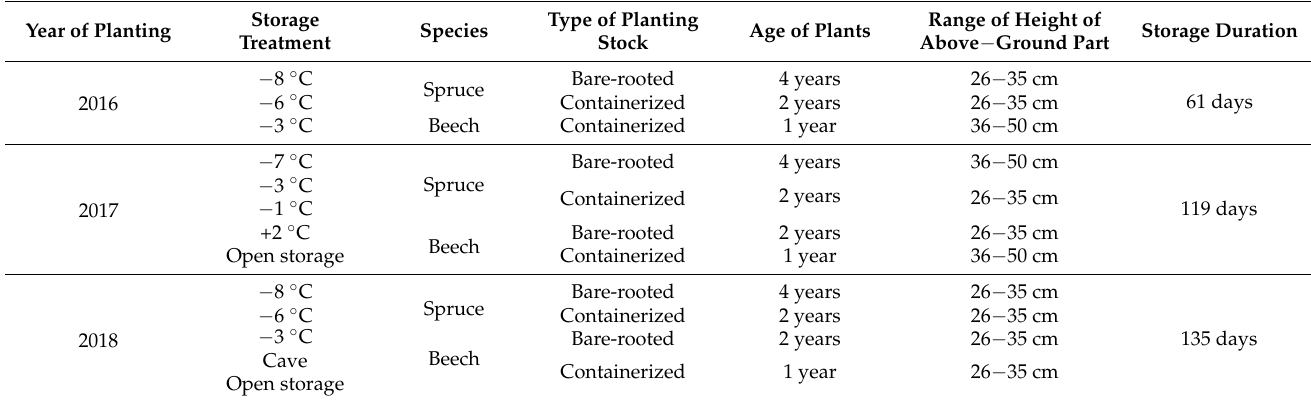
Table 1. An overview of tested treatments of overwinter